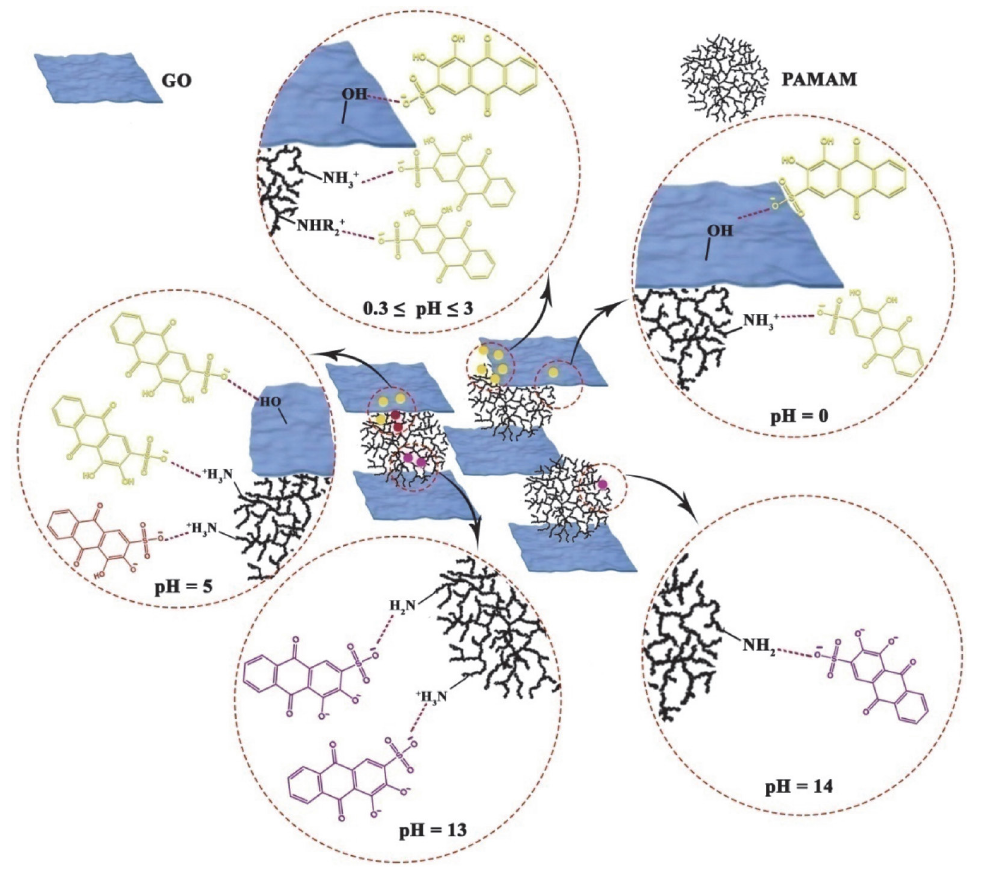
Figure 9. Adsorption sites of GO/PAMAM for different types of ARS molecules at different pHs.